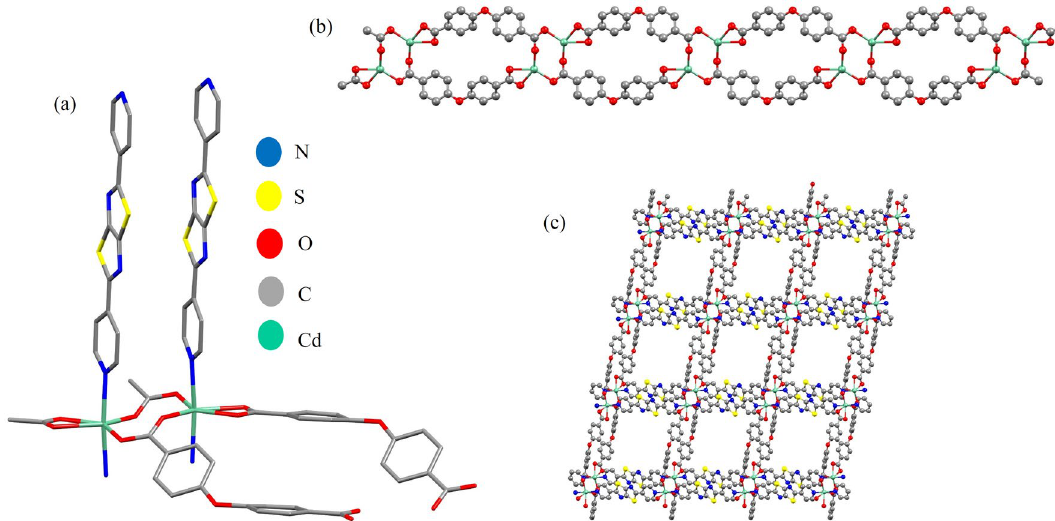
Figure 1. ( a ) View of coordination environment of the Cd(II) ions in the IUST-3; Symmetry codes: (i) − x , − y + 2, − z ; (ii) − x , − y + 2, − z + 1; (iii) x − 1, y + 1, z ; (iv) x + 1, y − 1, z , ( b ) 1D double-chain of Cd(II) ions and OBA ligands, ( c ) 2D pillared-layer framework of the IUST-3.